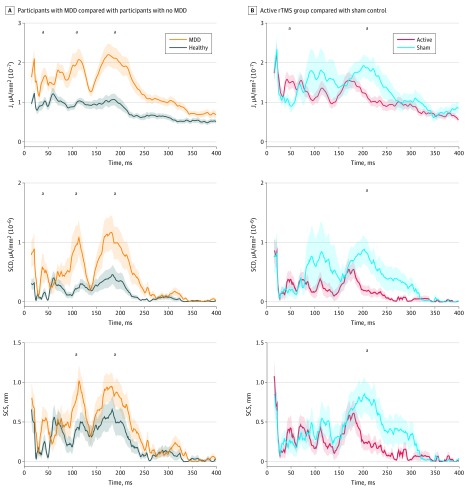
Current Density (J), Significant Current Density (SCD), and Significant Current Scattering (SCS) After Single Transcranial Magnetic Stimulation A, Participants with major depressive disorder (MDD) compared with healthy controls. B, Participants in active groups compared with participants in sham group. Shaded areas represent ±1 SEM.aP < .05.